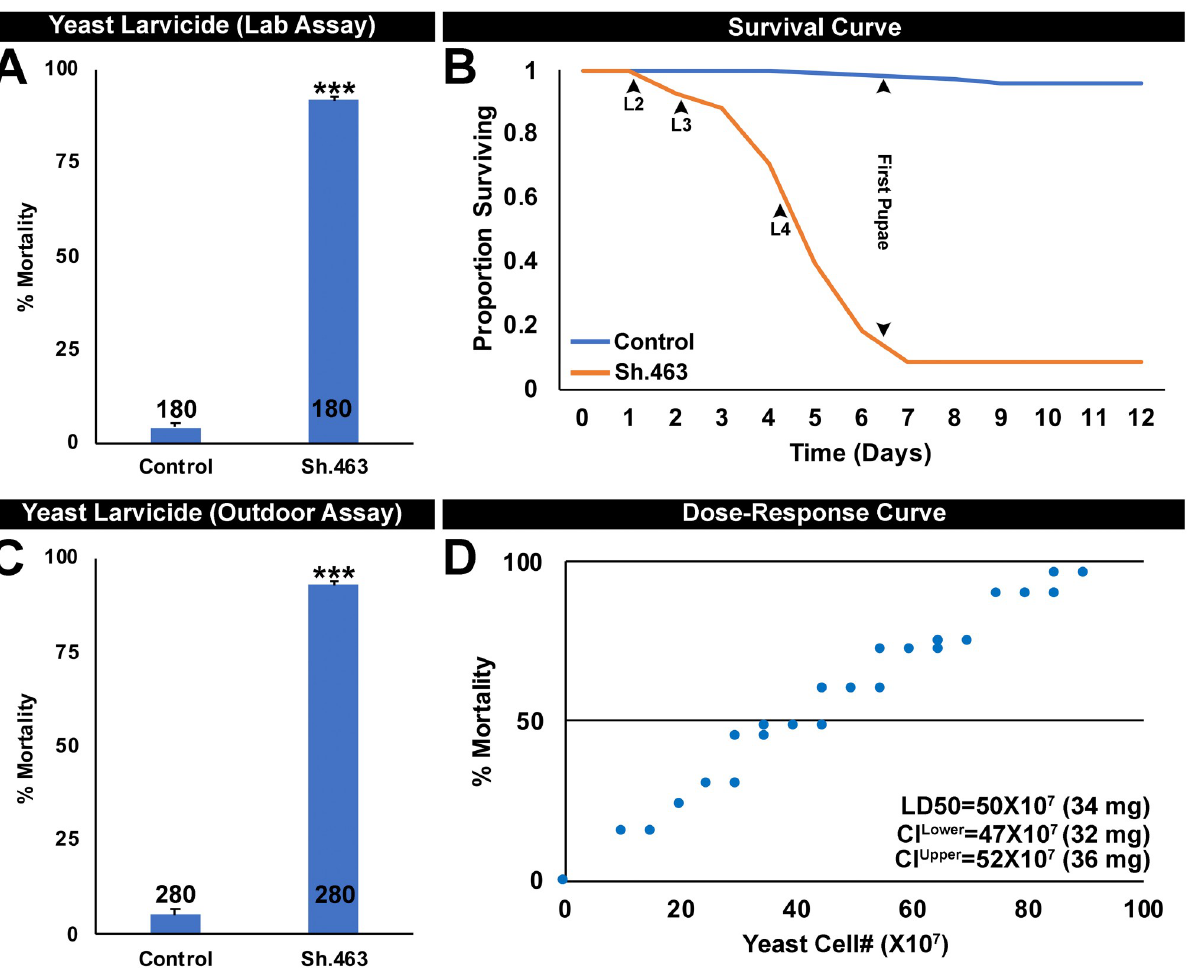
Fig 4. Sh.463 yeast IRP induces A . aegypti larval death. A . aegypti larval consumption of inactivated dried Sh.463 yeast IRP tablets induced significant larval mortality in laboratory (A) and outdoor semi-field (C) larvicide trials. In panels A and C, data are represented as mean percentage mortality; error bars represent SEM, and ��� = P < 0.001 in comparison to control yeast IRP-treated larvae. B. Consumption of inactivated dried Sh.463 yeast larvicide tablets induced larval mortality in the fourth instar (L4, days 4–6; compare to larvae fed with control yeast IRP that survived and pupariated). D. A dose-response curve depicting the dosage of Sh.463 yeast vs. the percentage mortality of A . aegypti larvae is shown; LD 50 = 34